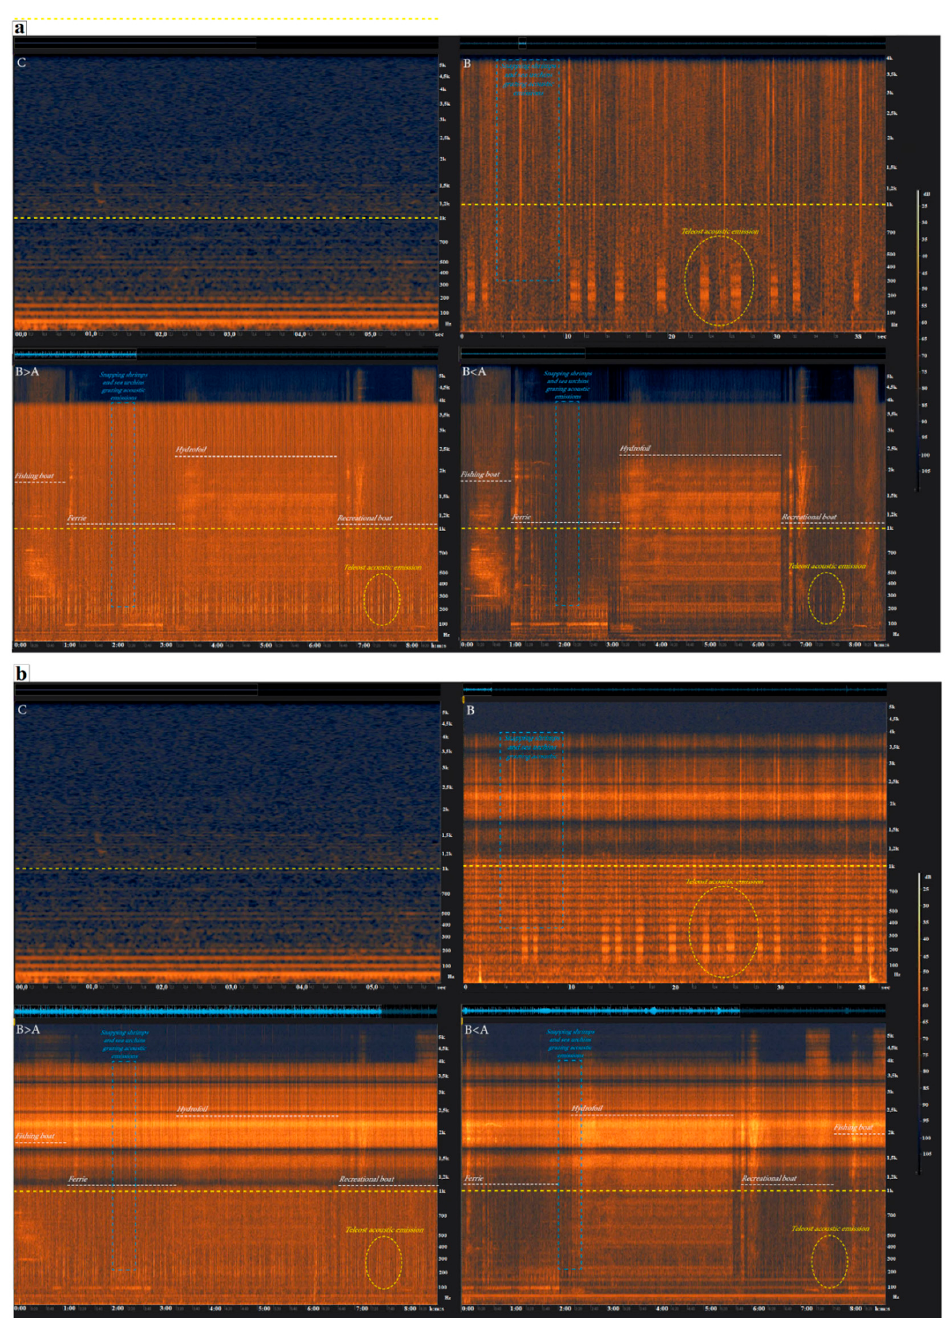
Figure 1. ( a ) Spectrogram (FFT 2048, Hanning window, frequency scale linear) of the four acoustic experimental conditions, showing the different spectral features; ( b ) Spectrogram (FFT 2048, Hanning window, frequency scale linear) of the four acoustic experimental conditions recorded inside the experimental aquarium, showing the different spectral characteris- tics. The yellow dotted line represents the upper hearing sensitivity threshold limit of elasmobranchs benthic demersal species [25,50]. C, control condition; B, biological condition; B > A, biological > anthropogenic condition; B < A, biological < anthropogenic